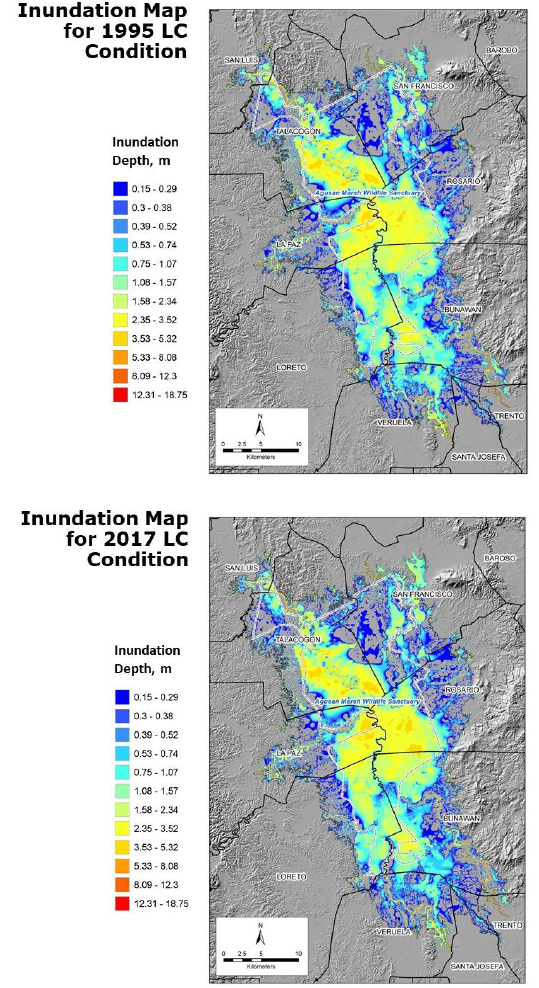
Figure 9. Example HEC-RAS model-simulated inundations (clipped for the Agusan Marsh portion) according to different land cover (LC) conditions (1995 and 2017).